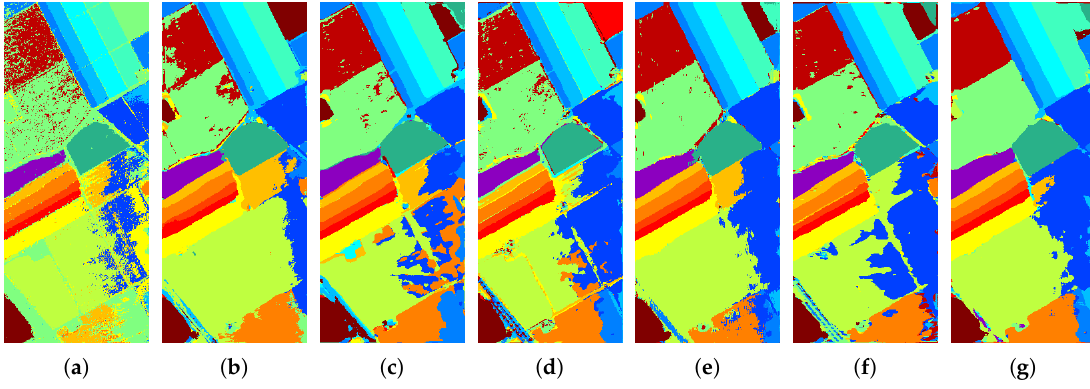
Figure 10. The classification maps of Salinas: ( a ) P-SVM-RBF, ( b ) P-CNN, ( c ) CRNN, ( d ) 3-D-CNN, ( e ) 3-D-CNN-LSTM, ( f ) L-CLSTM, and ( g ) PRCLSTM.